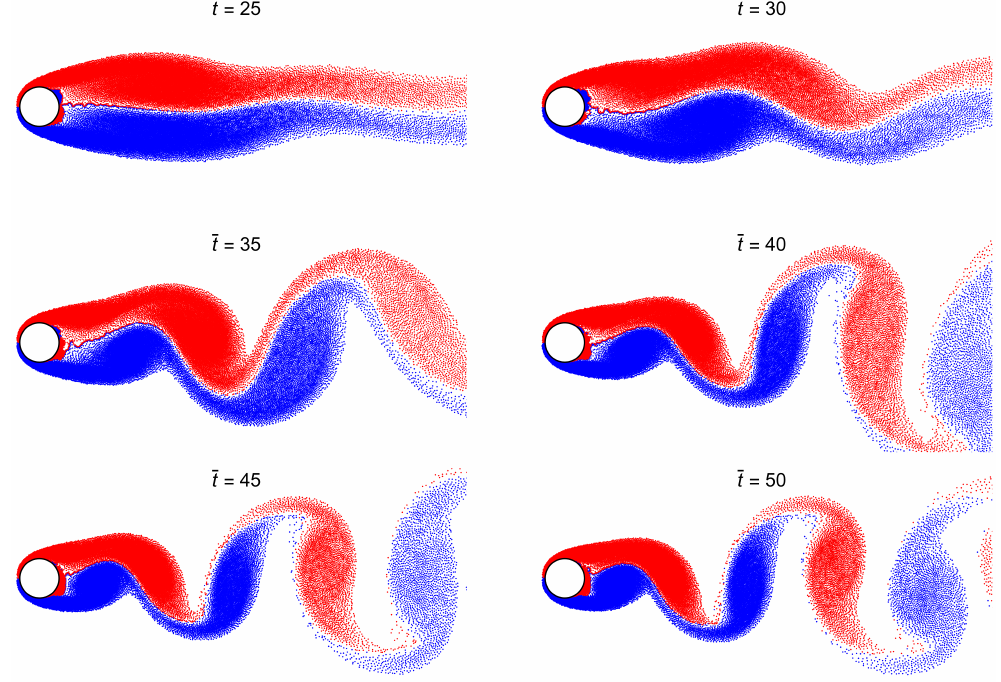
Figure 6. Instability development for vortex wake after the cylinder up to dimensionless time ¯ t = tV ∞ / D = 50.0; Re = 200; scheme T 0 is